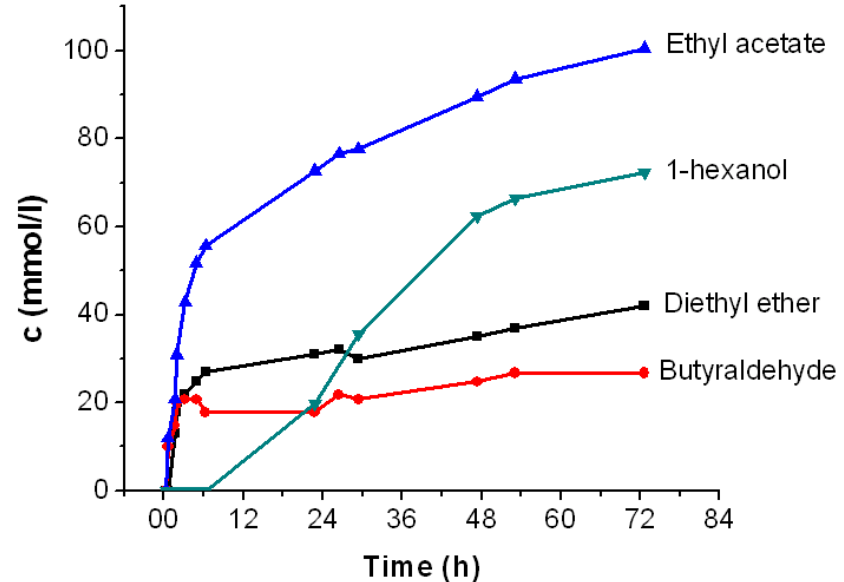
Figure 6. Ethyl acetate, 1-hexanol, diethyl ether and butyraldehyde concentrations as a function of